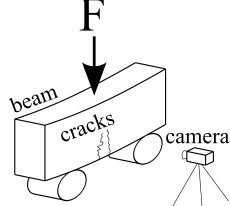
Figure 1. Experimental setup for the load test of a concrete beam